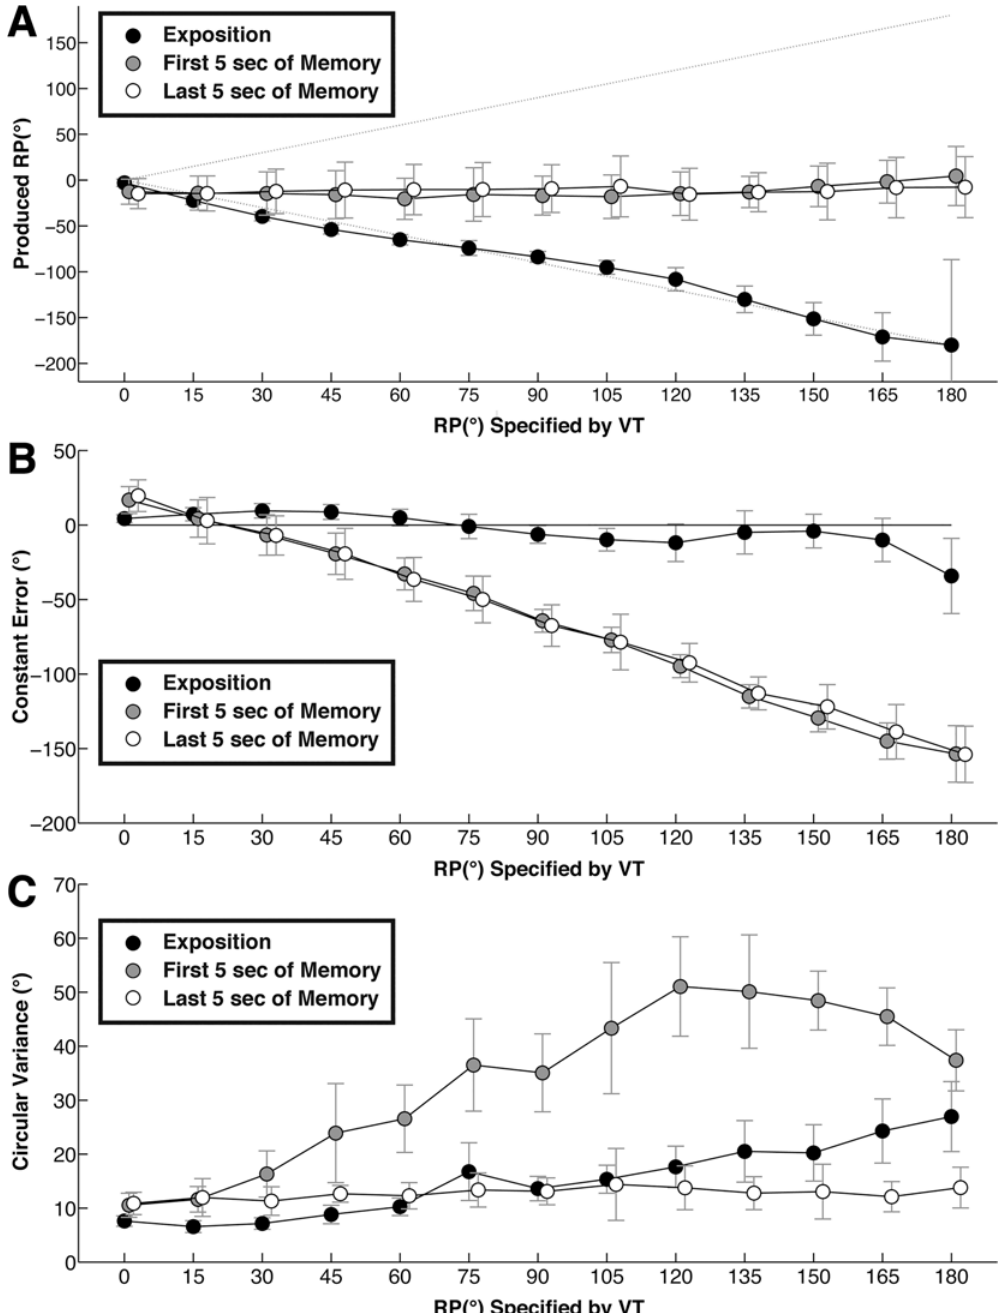
Fig 4. Scanning results. A: RP produced during the Exposition period (black circles), the first 5 s of the Memory period (gray circles) and the last 5 s of the Memory period (white circles), as a function of RP specified by the VT. B: Constant error produced during the Exposition period (black circles), the first 5 s (gray circles) and the last 5 s of the Memory period (white circles) as a function of specified RP. C: Circular variance produced during the Exposition period (black circles), the first 5 s (gray circles) and the last 5 s of the Memory period (white circles) as a function of specified RP. Vertical bars indicate between- subject standard